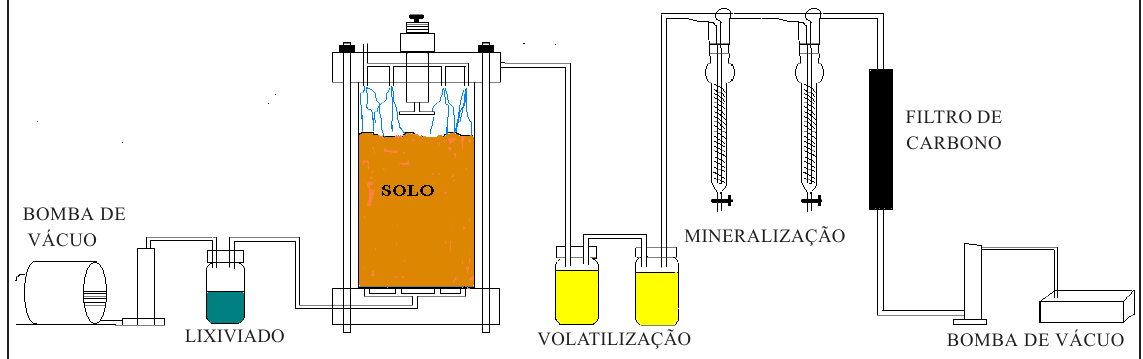
Figura 1. Esquema do